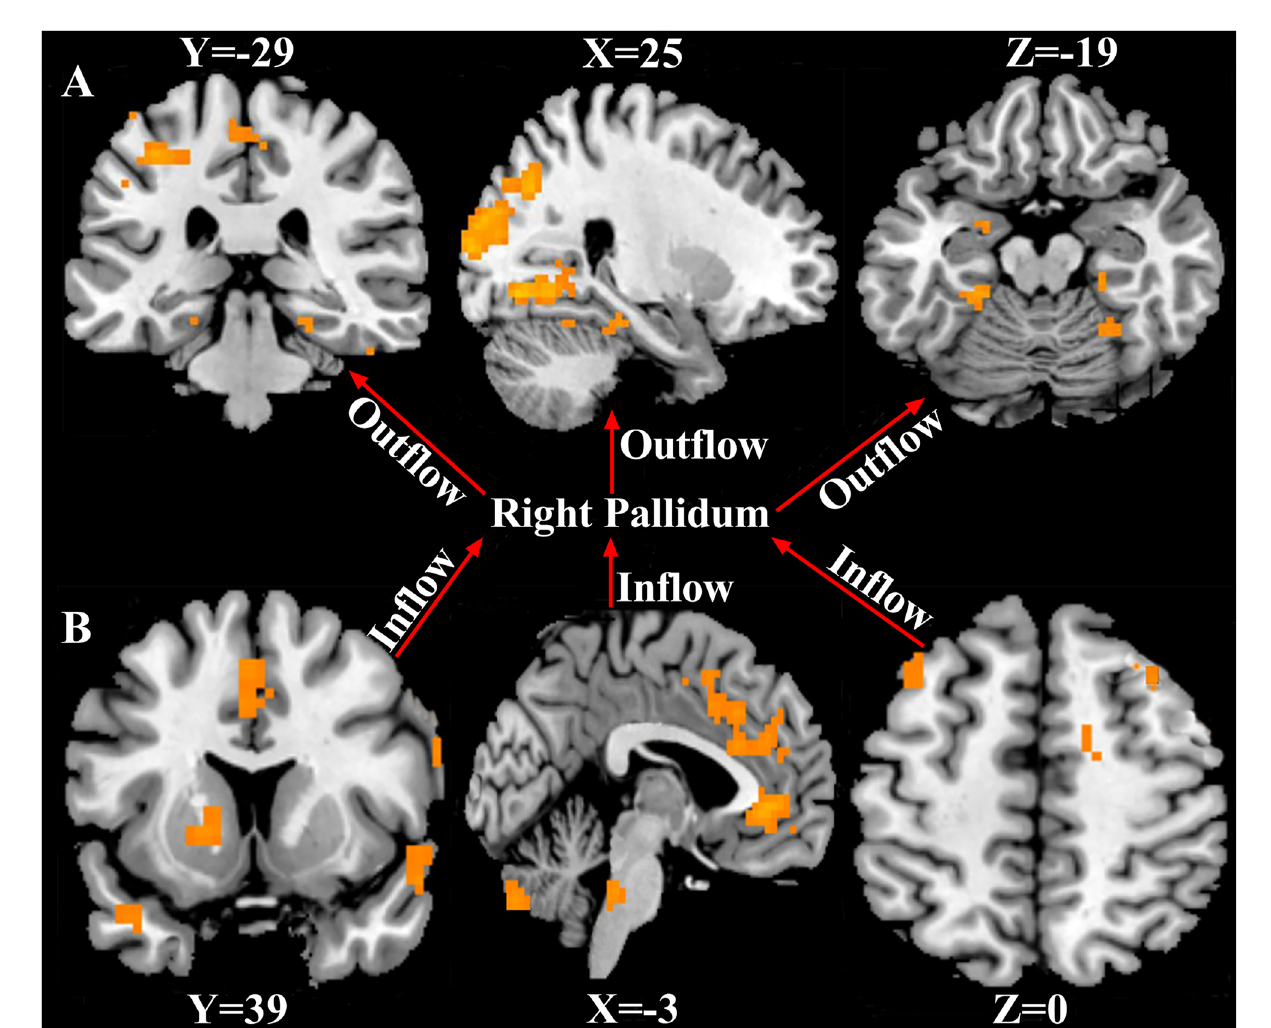
FIGURE3 Causal connectivity to and fro the right pallidum. (A) Causal effect from the right pallidum to significant whole-brain regions (Outflow). (B) Causal effect from the significant whole-brain regions to the right pallidum (Inflow). P < 0.05, FWE corrected. The arrows signify the direction of